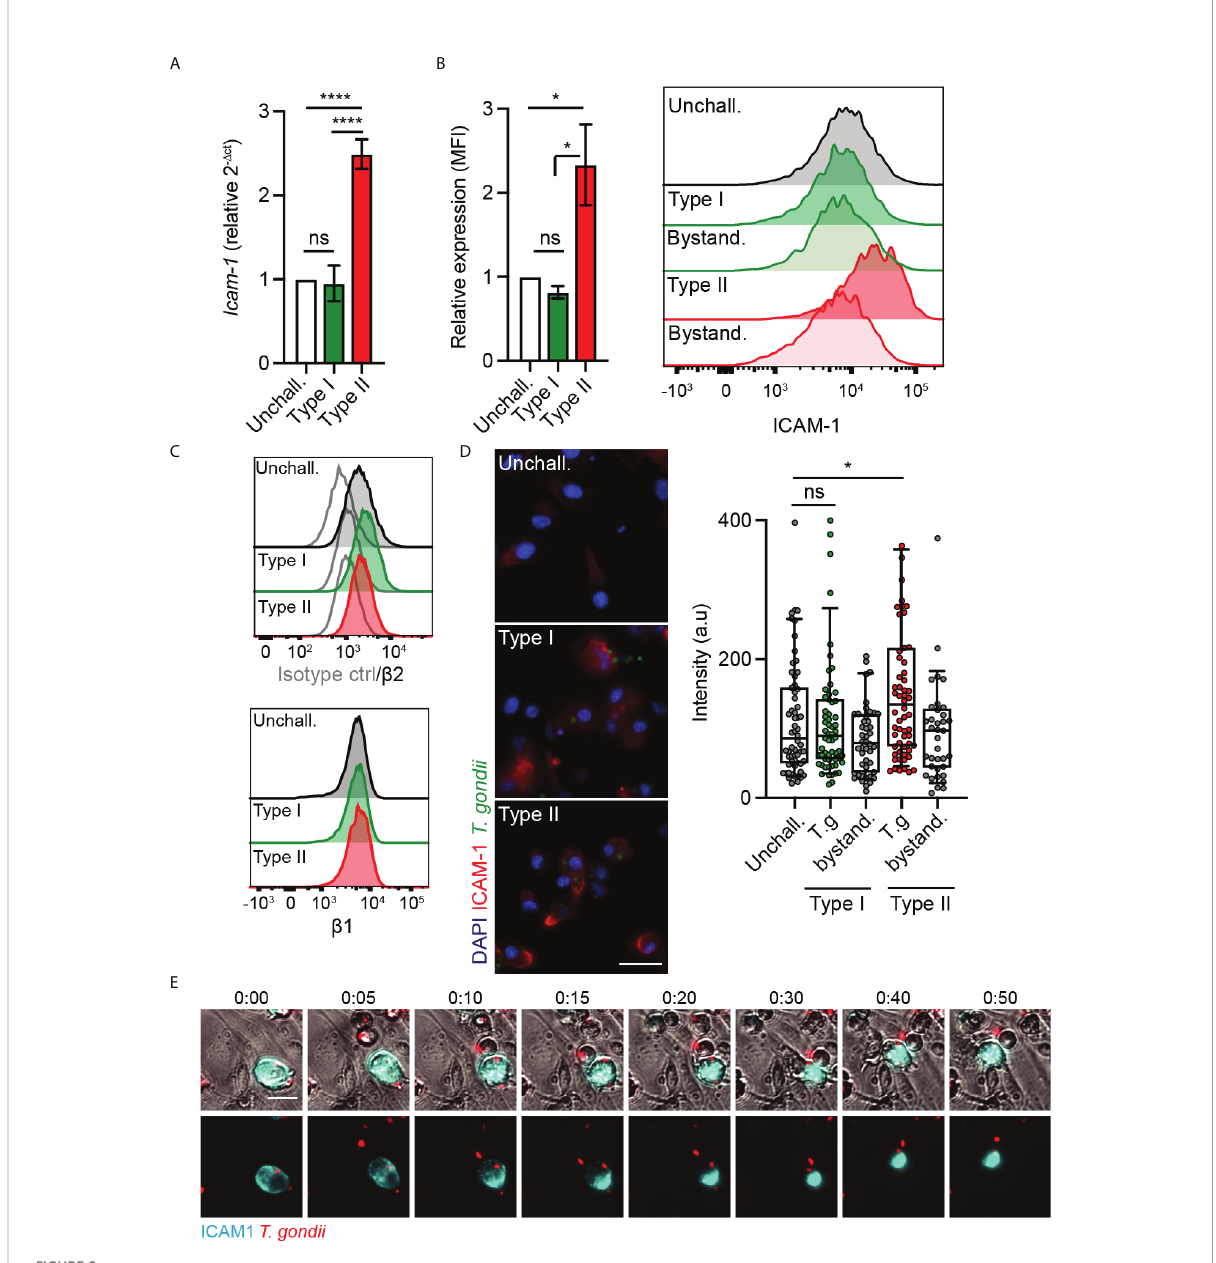
FIGURE 2 Parasite genotype-dependent upregulation and expression of ICAM-1 in DCs. (A) Icam-1 mRNA expression (2 - D Ct ) in DCs challenged with type I (RH) or II (ME49-PTG) T. gondii tachyzoites for 4 h, relative to unchallenged condition. (B) Bar graphs show relative expression of ICAM-1 (CD54) at 24 h post-challenge of CD11c + cells with T. gondii tachyzoites (GFP-expressing type I (RH) or type II (ME49-PTG), MOI 1), assessed by fl ow cytometry. Mean fl uorescence intensity (MFI) was related to that of unchallenged CD11c + in complete medium (CM, normalised to 1). Histogram shows fl uorescence intensity distributions for indicated cell populations. (C) Histograms show fl uorescence intensity distributions of b 2, b 1 integrin and isotype antibody control for indicated cell populations, respectively, and are representative of 3 independent experiments. (D) Micrographs represent DCs infected with GFP-expressing T. gondii type I (RH) or II (ME49-PTG) (green) and stained for ICAM-1 (red) and nuclei (blue). Box-and-whisker and scattered dot plots show ICAM-1 staining intensity of DCs. Each dot represents the corrected intensity fl uorescence of one cell (n = 40-62), as detailed in materials and methods. (E) Representative micrographs of live cell imaging of type II (ME49) T. gondii -challenged DCs stained with anti- ICAM-1 APC antibody, on bEnd.3 cell monolayers. Scale bar = 20 µm. Bar graphs represent the mean ± s.e.m of 3-4 independent experiments. * P < 0.05, **** P < 0.0001, ns: non-signi fi cant, by one-way ANOVA, Sidak ’ s post-hoc